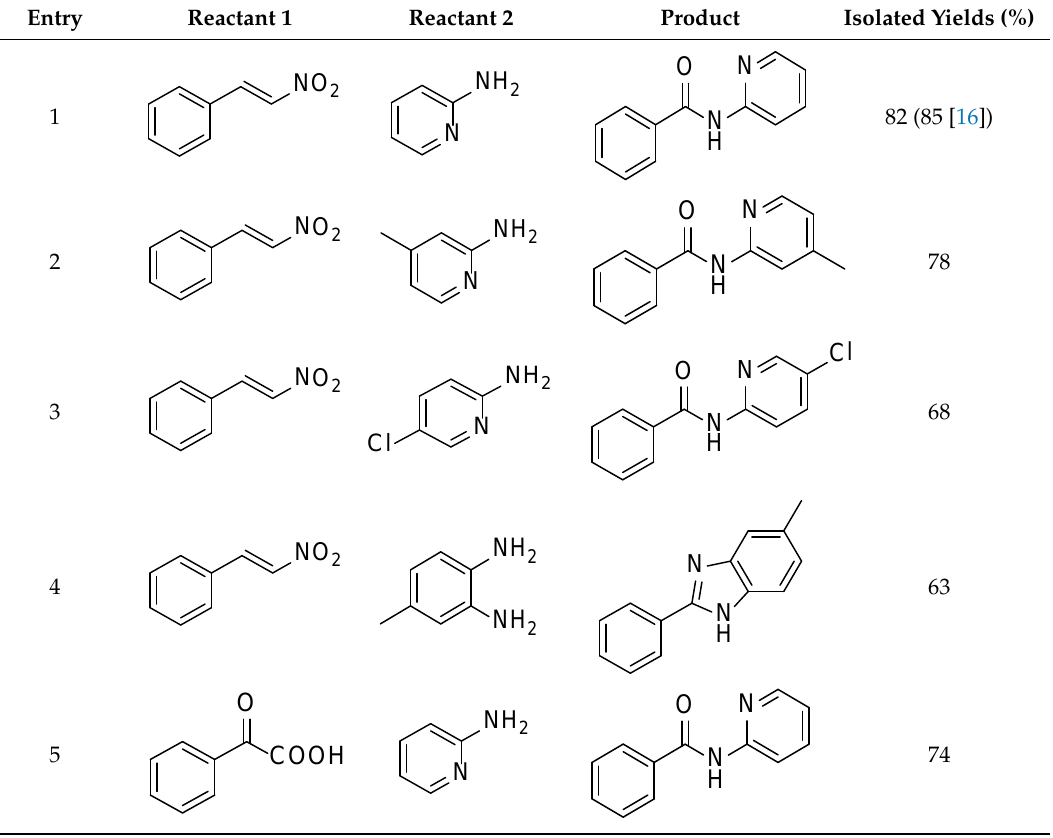
Optimization of reaction conditions. Figure S1: The presented simulated di ff raction patterns for Ni-based was based on the corresponding check CIF file of Ni-BDC compare with experimental patterns. Figure S2: The presented simulated di ff raction patterns for Fe-based (Fe) compare with experimental patterns. Figure S3: X-ray powder diffraction of Ni-BDC, Fe-BDC and Fe 2 Ni- was based on the corresponding check CIF file of MIL-53 (Fe) compare with experimental patterns. BDC. Figure S4: FT-IR spectra of the Ni-BDC, Fe-BDC, and Fe2Ni-BDC. Figure S5: EDX mapping point of Fe 2 Ni- BDC. Figure S4: FT-IR spectra of the Ni-BDC, Fe-BDC, and Fe2Ni-BDC. Figure S5: EDX mapping point of Fe 2 Ni- BDC. Figure S4: FT-IR spectra of the Ni-BDC, Fe-BDC, and Fe2Ni-BDC. Figure S5: EDX mapping point of Fe 2 Ni- BDC. Figure S4: FT-IR spectra of the Ni-BDC, Fe-BDC, and Fe2Ni-BDC. Figure S5: EDX mapping point of Fe 2 Ni- BDC. Figure S4: FT-IR spectra of the Ni-BDC, Fe-BDC, and Fe2Ni-BDC. Figure S5: EDX mapping point of Fe 2 Ni- Figure S3: X-ray powder di ff raction of Ni-BDC, Fe-BDC and Fe 2 Ni-BDC. Figure S4: FT-IR spectra BDC. Figure S4: FT-IR spectra of the Ni-BDC, Fe-BDC, and Fe2Ni-BDC. Figure S5: EDX mapping point of Fe 2 Ni- BDC. Figure S4: FT-IR spectra of the Ni-BDC, Fe-BDC, and Fe2Ni-BDC. Figure S5: EDX mapping point of Fe 2 Ni- BDC. Figure S4: FT-IR spectra of the Ni-BDC, Fe-BDC, and Fe2Ni-BDC. Figure S5: EDX mapping point of Fe 2 Ni- BDC. Figure S4: FT-IR spectra of the Ni-BDC, Fe-BDC, and Fe2Ni-BDC. Figure S5: EDX mapping point of Fe 2 Ni- BDC. Figure S4: FT-IR spectra of the Ni-BDC, Fe-BDC, and Fe2Ni-BDC. Figure S5: EDX mapping point of Fe 2 Ni- BDC. Figure S4: FT-IR spectra of the Ni-BDC, Fe-BDC, and Fe2Ni-BDC. Figure S5: EDX mapping point of Fe 2 Ni- BDC. Figure S4: FT-IR spectra of the Ni-BDC, Fe-BDC, and Fe2Ni-BDC. Figure S5: EDX mapping point of Fe 2 Ni- BDC. Figure S4: FT-IR spectra of the Ni-BDC, Fe-BDC, and Fe2Ni-BDC. Figure S5: EDX mapping point of Fe 2 Ni- BDC. Figure S4: FT-IR spectra of the Ni-BDC, Fe-BDC, and Fe2Ni-BDC. Figure S5: EDX mapping point of Fe 2 Ni- BDC. Figure S6: 1 H-NMR spectra of N-(pyridin-2-yl)benzamide. Figure S7: 13 C-NMR spectra of N-(pyridin-2- BDC. Figure S6: 1 H-NMR spectra of N-(pyridin-2-yl)benzamide. Figure S7: 13 C-NMR spectra of N-(pyridin-2- BDC. Figure S6: 1 H-NMR spectra of N-(pyridin-2-yl)benzamide. Figure S7: 13 C-NMR spectra of N-(pyridin-2- BDC. Figure S6: 1 H-NMR spectra of N-(pyridin-2-yl)benzamide. Figure S7: 13 C-NMR spectra of N-(pyridin-2- BDC. Figure S6: 1 H-NMR spectra of N-(pyridin-2-yl)benzamide. Figure S7: 13 C-NMR spectra of N-(pyridin-2- BDC. Figure S6: 1 H-NMR spectra of N-(pyridin-2-yl)benzamide. Figure S7: 13 C-NMR spectra of N-(pyridin-2- of the Ni-BDC, Fe-BDC, and Fe2Ni-BDC. Figure S5: EDX mapping point of Fe 2 Ni-BDC. Figure S6: BDC. Figure S6: 1 H-NMR spectra of N-(pyridin-2-yl)benzamide. Figure S7: 13 C-NMR spectra of N-(pyridin-2- BDC. Figure S6: 1 H-NMR spectra of N-(pyridin-2-yl)benzamide. Figure S7: 13 C-NMR spectra of N-(pyridin-2- BDC. Figure S6: 1 H-NMR spectra of N-(pyridin-2-yl)benzamide. Figure S7: 13 C-NMR spectra of N-(pyridin-2- BDC. Figure S6: 1 H-NMR spectra of N-(pyridin-2-yl)benzamide. Figure S7: 13 C-NMR spectra of N-(pyridin-2- BDC. Figure S6: 1 H-NMR spectra of N-(pyridin-2-yl)benzamide. Figure S7: 13 C-NMR spectra of N-(pyridin-2- BDC. Figure S6: 1 H-NMR spectra of N-(pyridin-2-yl)benzamide. Figure S7: 13 C-NMR spectra of N-(pyridin-2- BDC. Figure S6: 1 H-NMR spectra of N-(pyridin-2-yl)benzamide. Figure S7: 13 C-NMR spectra of N-(pyridin-2- BDC. Figure S6: 1 H-NMR spectra of N-(pyridin-2-yl)benzamide. Figure S7: 13 C-NMR spectra of N-(pyridin-2- BDC. Figure S6: 1 H-NMR spectra of N-(pyridin-2-yl)benzamide. Figure S7: 13 C-NMR spectra of N-(pyridin-2- yl)benzamide. Figure S8: 1 H-NMR spectra of N-(4-methylpyridin-2-yl)benzamide. Figure S9: 13 C-NMR spectra yl)benzamide. Figure S8: 1 H-NMR spectra of N-(4-methylpyridin-2-yl)benzamide. Figure S9: 13 C-NMR spectra 1 H-NMR spectra of N-(pyridin-2-yl)benzamide. Figure S7: 13 C-NMR spectra of yl)benzamide. Figure S8: 1 H-NMR spectra of N-(4-methylpyridin-2-yl)benzamide. Figure S9: 13 C-NMR spectra yl)benzamide. Figure S8: 1 H-NMR spectra of N-(4-methylpyridin-2-yl)benzamide. Figure S9: 13 C-NMR spectra yl)benzamide. Figure S8: 1 H-NMR spectra of N-(4-methylpyridin-2-yl)benzamide. Figure S9: 13 C-NMR spectra yl)benzamide. Figure S8: 1 H-NMR spectra of N-(4-methylpyridin-2-yl)benzamide. Figure S9: 13 C-NMR spectra yl)benzamide. Figure S8: 1 H-NMR spectra of N-(4-methylpyridin-2-yl)benzamide. Figure S9: 13 C-NMR spectra yl)benzamide. Figure S8: 1 H-NMR spectra of N-(4-methylpyridin-2-yl)benzamide. Figure S9: 13 C-NMR spectra yl)benzamide. Figure S8: 1 H-NMR spectra of N-(4-methylpyridin-2-yl)benzamide. Figure S9: 13 C-NMR spectra yl)benzamide. Figure S8: 1 H-NMR spectra of N-(4-methylpyridin-2-yl)benzamide. Figure S9: 13 C-NMR spectra yl)benzamide. Figure S8: 1 H-NMR spectra of N-(4-methylpyridin-2-yl)benzamide. Figure S9: 13 C-NMR spectra yl)benzamide. Figure S8: 1 H-NMR spectra of N-(4-methylpyridin-2-yl)benzamide. Figure S9: 13 C-NMR spectra yl)benzamide. Figure S8: 1 H-NMR spectra of N-(4-methylpyridin-2-yl)benzamide. Figure S9: 13 C-NMR spectra yl)benzamide. Figure S8: 1 H-NMR spectra of N-(4-methylpyridin-2-yl)benzamide. Figure S9: 13 C-NMR spectra yl)benzamide. Figure S8: 1 H-NMR spectra of N-(4-methylpyridin-2-yl)benzamide. Figure S9: 13 C-NMR spectra of N-(4-methylpyridin-2-yl)benzamide. Figure S10: 1 H-NMR spectra of 5-methyl-2-phenyl-1H- of N-(4-methylpyridin-2-yl)benzamide. Figure S10: 1 H-NMR spectra of 5-methyl-2-phenyl-1H- of N-(4-methylpyridin-2-yl)benzamide. Figure S10: 1 H-NMR spectra of 5-methyl-2-phenyl-1H- of N-(4-methylpyridin-2-yl)benzamide. Figure S10: 1 H-NMR spectra of 5-methyl-2-phenyl-1H- of N-(4-methylpyridin-2-yl)benzamide. Figure S10: 1 H-NMR spectra of 5-methyl-2-phenyl-1H- of N-(4-methylpyridin-2-yl)benzamide. Figure S10: 1 H-NMR spectra of 5-methyl-2-phenyl-1H- of N-(4-methylpyridin-2-yl)benzamide. Figure S10: 1 H-NMR spectra of 5-methyl-2-phenyl-1H- of N-(4-methylpyridin-2-yl)benzamide. Figure S10: 1 H-NMR spectra of 5-methyl-2-phenyl-1H- of N-(4-methylpyridin-2-yl)benzamide. Figure S10: 1 H-NMR spectra of 5-methyl-2-phenyl-1H- of N-(4-methylpyridin-2-yl)benzamide. Figure S10: 1 H-NMR spectra of 5-methyl-2-phenyl-1H- of N-(4-methylpyridin-2-yl)benzamide. Figure S10: 1 H-NMR spectra of 5-methyl-2-phenyl-1H- of N-(4-methylpyridin-2-yl)benzamide. Figure S10: 1 H-NMR spectra of 5-methyl-2-phenyl-1H- of N-(4-methylpyridin-2-yl)benzamide. Figure S10: 1 H-NMR spectra of 5-methyl-2-phenyl-1H- of N-(4-methylpyridin-2-yl)benzamide. Figure S10: 1 H-NMR spectra of 5-methyl-2-phenyl-1H- of N-(4-methylpyridin-2-yl)benzamide. Figure S10: 1 H-NMR spectra of 5-methyl-2-phenyl-1H- benzo[d]imidazole. Figure S11: 13 C-NMR spectra of 5-methyl-2-phenyl- 1H-benzo[d]imidazole. Figure S12: 1 H- benzo[d]imidazole. Figure S11: 13 C-NMR spectra of 5-methyl-2-phenyl- 1H-benzo[d]imidazole. Figure S12: 1 H- benzo[d]imidazole. Figure S11: 13 C-NMR spectra of 5-methyl-2-phenyl- 1H-benzo[d]imidazole. Figure S12: 1 H- benzo[d]imidazole. Figure S11: 13 C-NMR spectra of 5-methyl-2-phenyl- 1H-benzo[d]imidazole. Figure S12: 1 H- benzo[d]imidazole. Figure S11: 13 C-NMR spectra of 5-methyl-2-phenyl- 1H-benzo[d]imidazole. Figure S12: 1 H- benzo[d]imidazole. Figure S11: 13 C-NMR spectra of 5-methyl-2-phenyl- 1H-benzo[d]imidazole. Figure S12: 1 H- benzo[d]imidazole. Figure S11: 13 C-NMR spectra of 5-methyl-2-phenyl- 1H-benzo[d]imidazole. Figure S12: 1 H- benzo[d]imidazole. Figure S11: 13 C-NMR spectra of 5-methyl-2-phenyl- 1H-benzo[d]imidazole. Figure S12: 1 H- benzo[d]imidazole. Figure S11: 13 C-NMR spectra of 5-methyl-2-phenyl- 1H-benzo[d]imidazole. Figure S12: 1 H- benzo[d]imidazole. Figure S11: 13 C-NMR spectra of 5-methyl-2-phenyl- 1H-benzo[d]imidazole. Figure S12: 1 H- benzo[d]imidazole. Figure S11: 13 C-NMR spectra of 5-methyl-2-phenyl- 1H-benzo[d]imidazole. Figure S12: 1 H- benzo[d]imidazole. Figure S11: 13 C-NMR spectra of 5-methyl-2-phenyl- 1H-benzo[d]imidazole. Figure S12: 1 H- benzo[d]imidazole. Figure S11: 13 C-NMR spectra of 5-methyl-2-phenyl- 1H-benzo[d]imidazole. Figure S12: 1 H- NMR spectra of N-(5-chloropyridin-2-yl)benzamide. Figure S13: 13 C-NMR spectra of N-(5-chloropyridin-2- NMR spectra of N-(5-chloropyridin-2-yl)benzamide. Figure S13: 13 C-NMR spectra of N-(5-chloropyridin-2- NMR spectra of N-(5-chloropyridin-2-yl)benzamide. Figure S13: 13 C-NMR spectra of N-(5-chloropyridin-2- NMR spectra of N-(5-chloropyridin-2-yl)benzamide. Figure S13: 13 C-NMR spectra of N-(5-chloropyridin-2- NMR spectra of N-(5-chloropyridin-2-yl)benzamide. Figure S13: 13 C-NMR spectra of N-(5-chloropyridin-2- NMR spectra of N-(5-chloropyridin-2-yl)benzamide. Figure S13: 13 C-NMR spectra of N-(5-chloropyridin-2- NMR spectra of N-(5-chloropyridin-2-yl)benzamide. Figure S13: 13 C-NMR spectra of N-(5-chloropyridin-2- NMR spectra of N-(5-chloropyridin-2-yl)benzamide. Figure S13: 13 C-NMR spectra of N-(5-chloropyridin-2- NMR spectra of N-(5-chloropyridin-2-yl)benzamide. Figure S13: 13 C-NMR spectra of N-(5-chloropyridin-2- NMR spectra of N-(5-chloropyridin-2-yl)benzamide. Figure S13: 13 C-NMR spectra of N-(5-chloropyridin-2- NMR spectra of N-(5-chloropyridin-2-yl)benzamide. Figure S13: 13 C-NMR spectra of N-(5-chloropyridin-2- NMR spectra of N-(5-chloropyridin-2-yl)benzamide. Figure S13: 13 C-NMR spectra of N-(5-chloropyridin-2- NMR spectra of N-(5-chloropyridin-2-yl)benzamide. Figure S13: 13 C-NMR spectra of N-(5-chloropyridin-2- yl)benzamide. Figure S14: 1H-NMR spectra of N-(pyridin-2-yl)benzamide. Figure S15: 13 C-NMR spectra of N- yl)benzamide. Figure S14: 1H-NMR spectra of N-(pyridin-2-yl)benzamide. Figure S15: 13 C-NMR spectra of N- yl)benzamide. Figure S14: 1H-NMR spectra of N-(pyridin-2-yl)benzamide. Figure S15: 13 C-NMR spectra of N- yl)benzamide. Figure S14: 1H-NMR spectra of N-(pyridin-2-yl)benzamide. Figure S15: 13 C-NMR spectra of N- yl)benzamide. Figure S14: 1H-NMR spectra of N-(pyridin-2-yl)benzamide. Figure S15: 13 C-NMR spectra of N- yl)benzamide. Figure S14: 1H-NMR spectra of N-(pyridin-2-yl)benzamide. Figure S15: 13 C-NMR spectra of N- yl)benzamide. Figure S14: 1H-NMR spectra of N-(pyridin-2-yl)benzamide. Figure S15: 13 C-NMR spectra of N- yl)benzamide. Figure S14: 1H-NMR spectra of N-(pyridin-2-yl)benzamide. Figure S15: 13 C-NMR spectra of N- yl)benzamide. Figure S14: 1H-NMR spectra of N-(pyridin-2-yl)benzamide. Figure S15: 13 C-NMR spectra of N- yl)benzamide. Figure S14: 1H-NMR spectra of N-(pyridin-2-yl)benzamide. Figure S15: 13 C-NMR spectra of N- yl)benzamide. Figure S14: 1H-NMR spectra of N-(pyridin-2-yl)benzamide. Figure S15: 13 C-NMR spectra of N- yl)benzamide. Figure S14: 1H-NMR spectra of N-(pyridin-2-yl)benzamide. Figure S15: 13 C-NMR spectra of N- yl)benzamide. Figure S14: 1H-NMR spectra of N-(pyridin-2-yl)benzamide. Figure S15: 13 C-NMR spectra of N- yl)benzamide. Figure S14: 1H-NMR spectra of N-(pyridin-2-yl)benzamide. Figure S15: 13 C-NMR spectra of N- (pyridin-2-yl)benzamide. (pyridin-2-yl)benzamide. (pyridin-2-yl)benzamide. (pyridin-2-yl)benzamide. (pyridin-2-yl)benzamide. (pyridin-2-yl)benzamide. (pyridin-2-yl)benzamide. (pyridin-2-yl)benzamide. (pyridin-2-yl)benzamide. (pyridin-2-yl)benzamide. (pyridin-2-yl)benzamide. Author Contributions: Data curation, O.K.T.N., V.H.N. and N.V.T.; Formal analysis, T.V.T. and S.T.D.; Methodology, T.V.T., V.H.N., N.V.T. and T.V.N.; Writing—original draft, O.K.T.N.; Writing—review and editing, L.G.B., D-.V.N.V., T.V.N., S.-S.H. and S.T.D. Funding: This research was funded by NTTU Foundation for Science and Technology Development under grant number 2018.01.18/HĐ -KHCN. Author Contributions: Data curation, O.K.T.N., V.H.N. and N.V.T.; Formal analysis, T.V.T. and S.T.D.; Methodology, T.V.T., V.H.N., N.V.T. and T.V.N.; Writing—original draft, O.K.T.N.; Writing—review and editing, L.G.B., D-.V.N.V., T.V.N., S.-S.H. and S.T.D. Funding: This research was funded by NTTU Foundation for Science and Technology Development under grant number 2018.01.18/HĐ -KHCN.